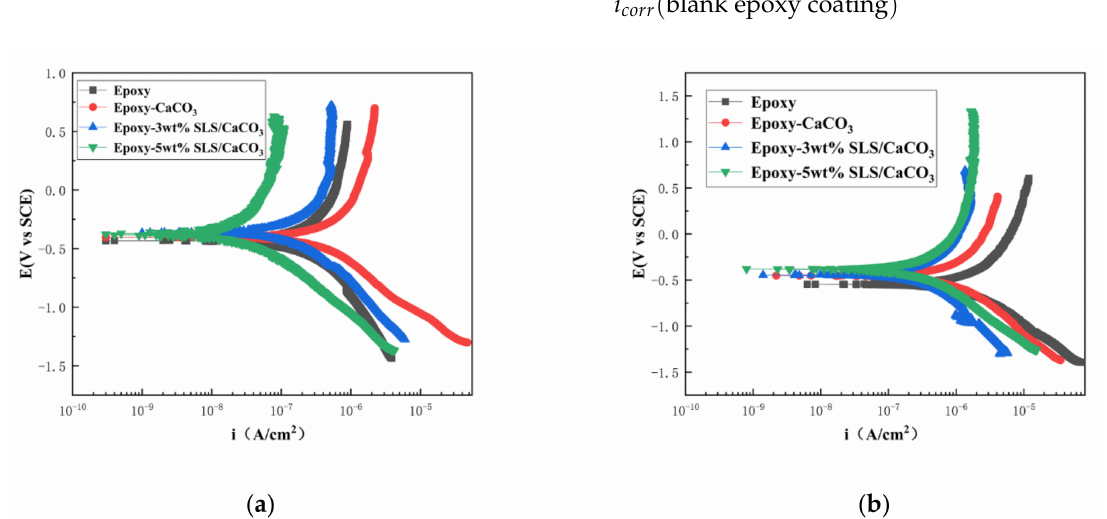
Figure 11. Potentiodynamic polarization curves for the epoxy coating containing CaCO 3 microparticles with or without SLS as well as the pure epoxy coating, measured after ( a ) 5 days and ( b ) 15 days exposure in the SCP solutions with 3.5 wt%